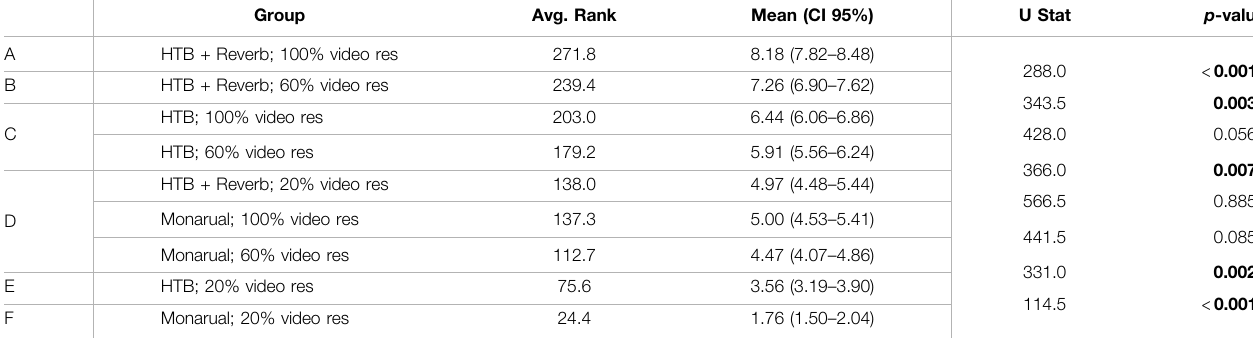
TABLE 2 | Audio-visual quality scores pairwise (step-down) comparison using Mann-Whitney U tests. The table description is the same as Table 1 .